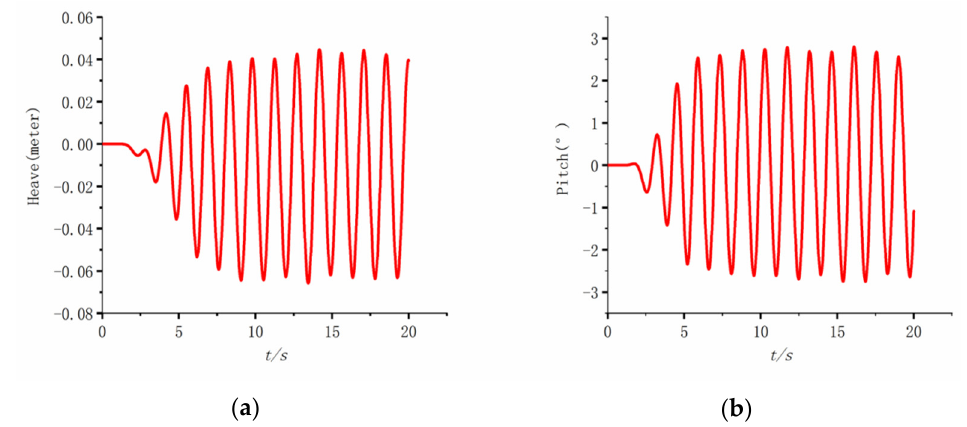
Figure 14. Time history curve of KVLCC2 hull at V = 15.5 knots (Case CK5). ( a ) Heave; ( b ) Pitch.